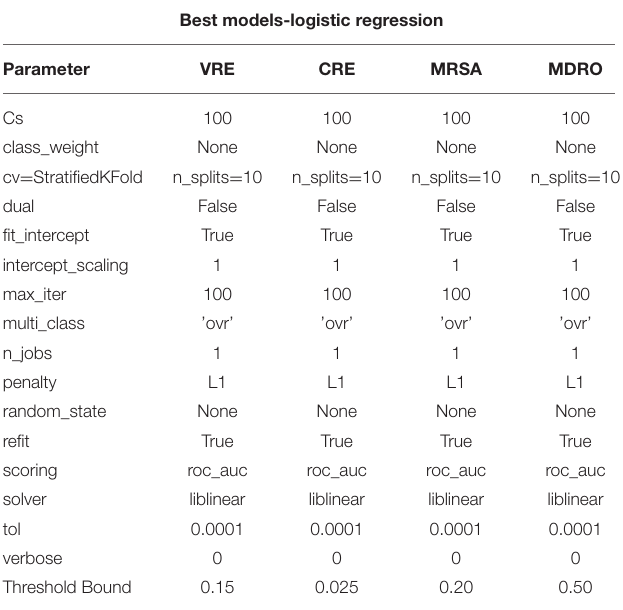
TABLE 1 | Model parameters for best performing logistic regression